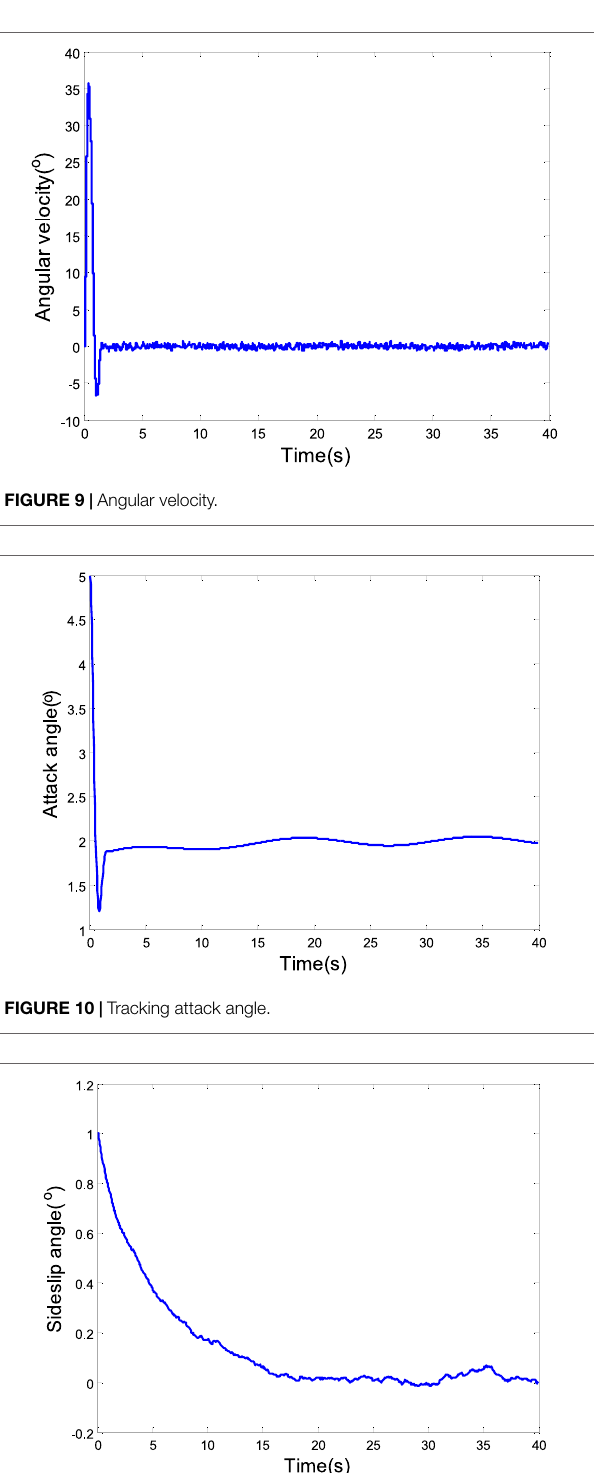
FIGURE 11 | Tacking side slip